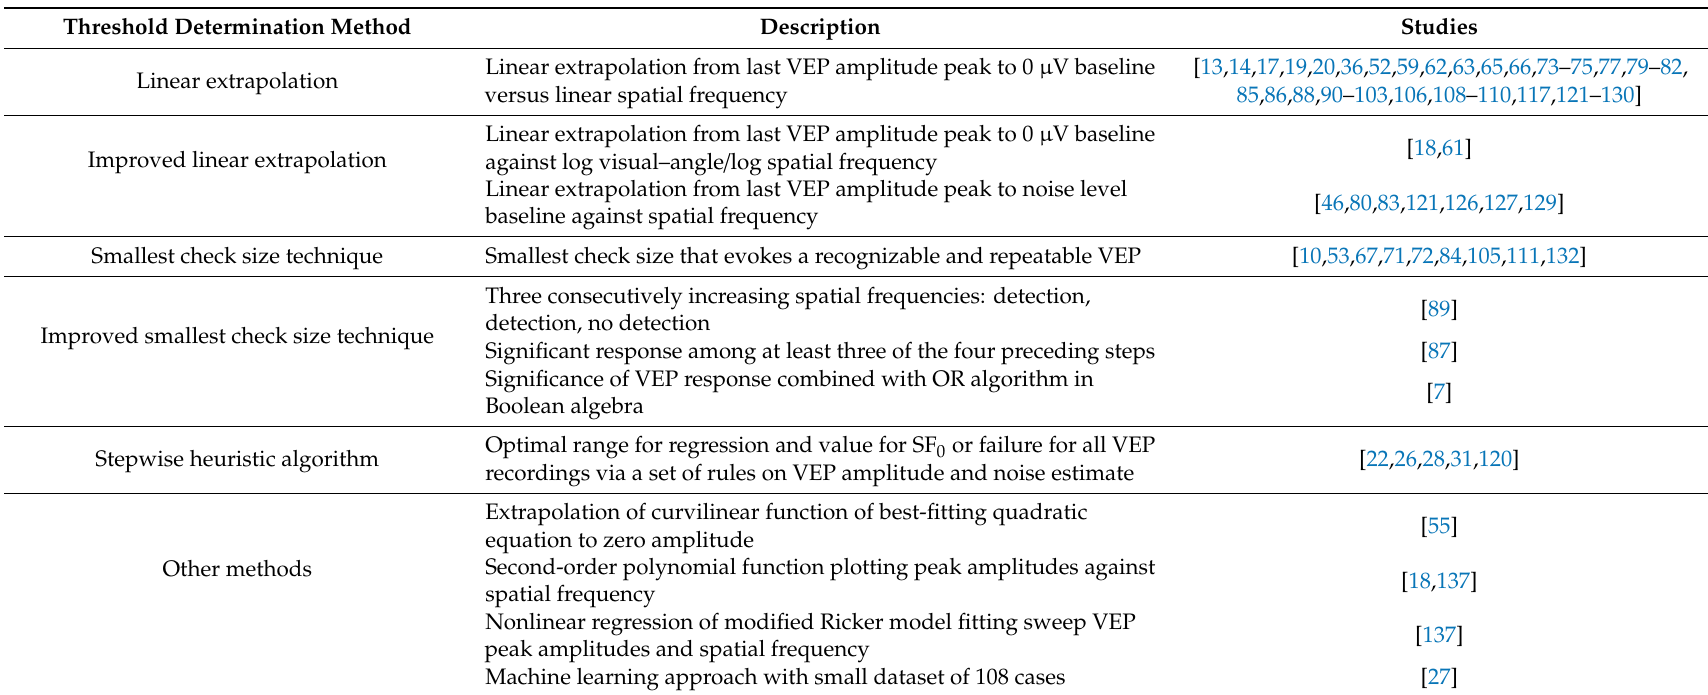
Table 1. Threshold determination methods in VEP acuity